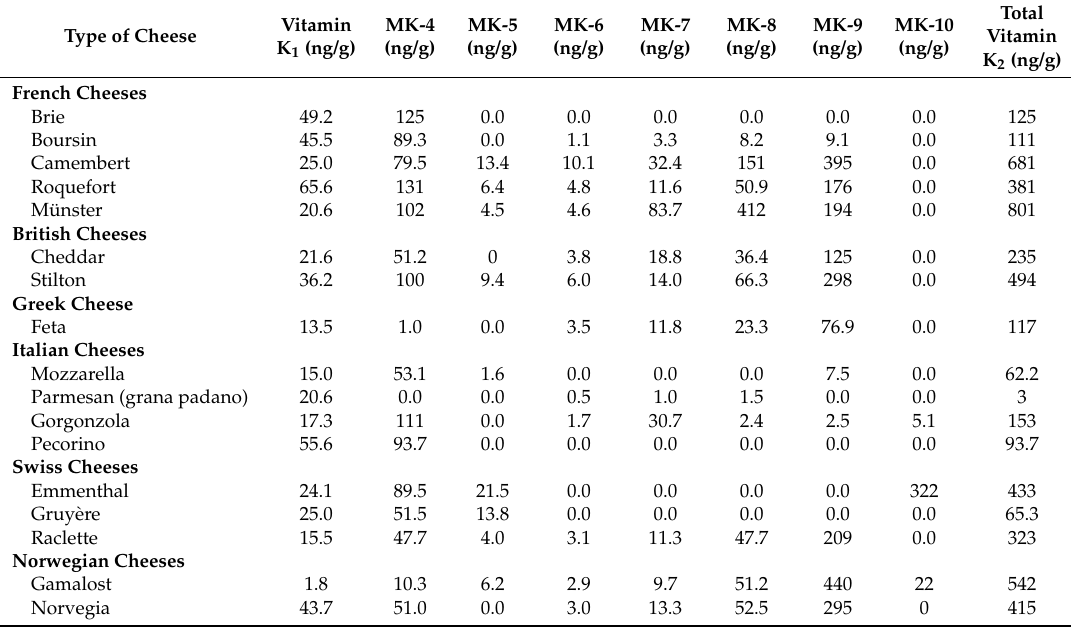
Table 2. Vitamin K content of various European